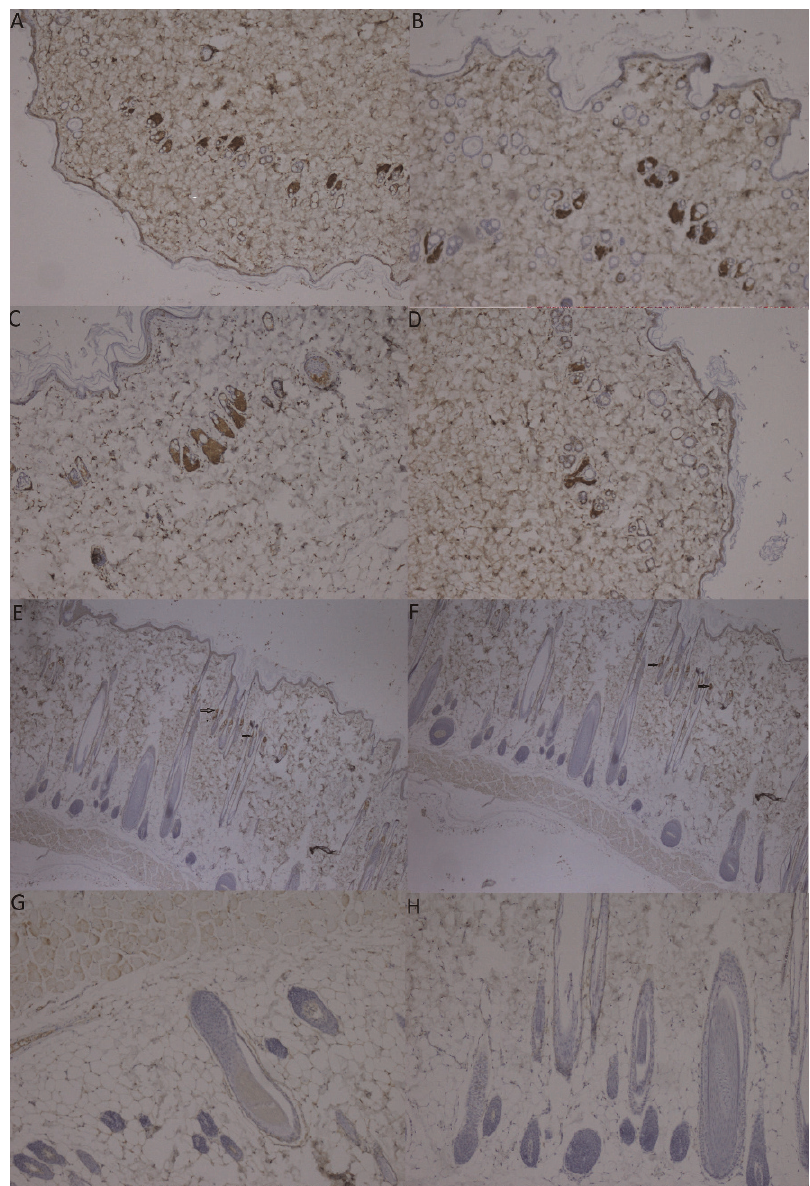
Figure 4 - Immunohistochemical staining of the ER (estrogen receptor) in skin biopsies from the CMC-free group (A), the 0.5% CMC-plus group (B), the group treated with the n-hexane extract at a dose of 100 mg/kg (C), the group treated with the n-hexane extract at a dose of 200 mg/kg (D), the group treated with the ethyl acetate extract at a dose of 100 mg/kg (E), the group treated with the ethyl acetate extract at a dose of 200 mg/kg (F), the group treated with the ethanol extract at a dose of 100 mg/kg (G), and the group treated with the ethanol extract at a dose of 200 mg/kg (H) (magnification, 40X). The arrows indicate positively stained cells in the dermal